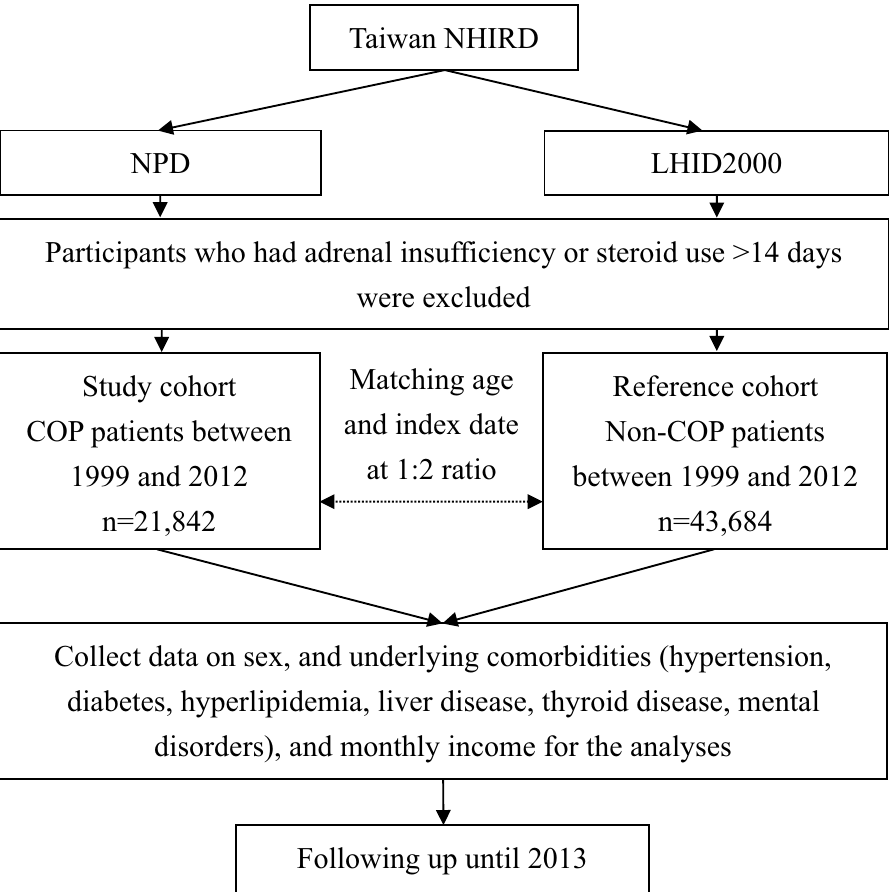
Figure 1. Flowchart of this study. NHIRD, National Health Insurance Research Database; NPD, Nationwide Poison Database; LHID2000, Longitudinal Health Insurance Database